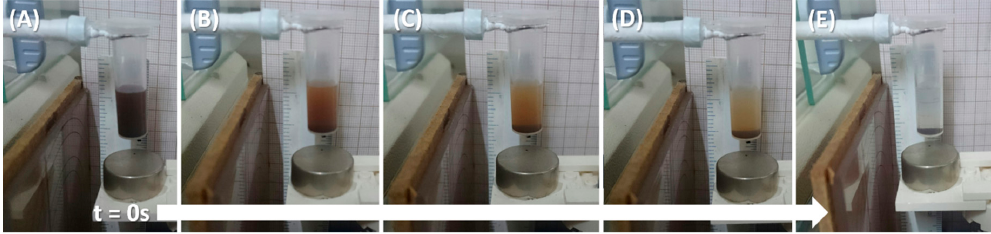
Figure 16. ( A – E ) Monitoring the magnetophoresis of NP@DTPA in the presence of a Nd 2 Fe 14 B magnet, as a function of time by means of an external weight device placed on the analytical balance pan (only